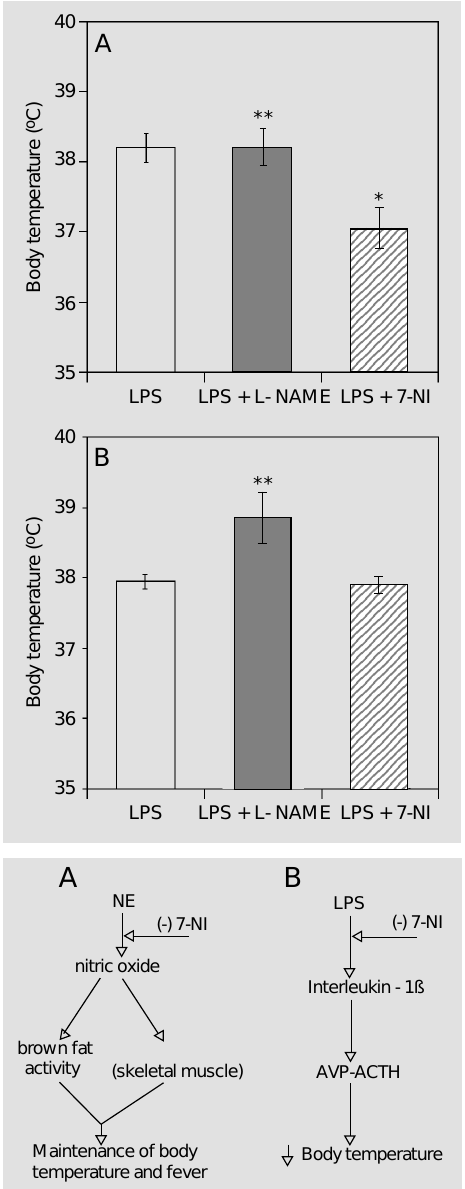
Figure 4 - Body temperature of rats injected with 100 µg/kg lipo- polysaccharide (LPS) combined with 30 mg/kg N G -nitro-L-argi- nine methyl ester (L-NAME) and with 30 mg/kg 7-nitroindazole (7- NI) compared to rats that re- ceived only LPS. Comparison at a single time; second (A) and fourth (B) hour after the nitric oxide inhibitor or vehicle injec- tion. Data are reported as mean body temperature (± SEM). *P<0.05 LPS compared to LPS/ 7-NI and **P<0.05 LPS/L-NAME compared to LPS/7-NI (Tukey- Kramer multiple comparison test). N = 5 in each group.